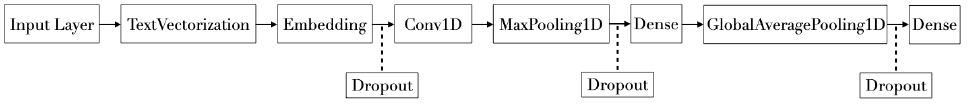
Figure 1. The shallow CNN model used in our experiments. The network is able to outperform any other existing approach on the same dataset and is further analysed in our